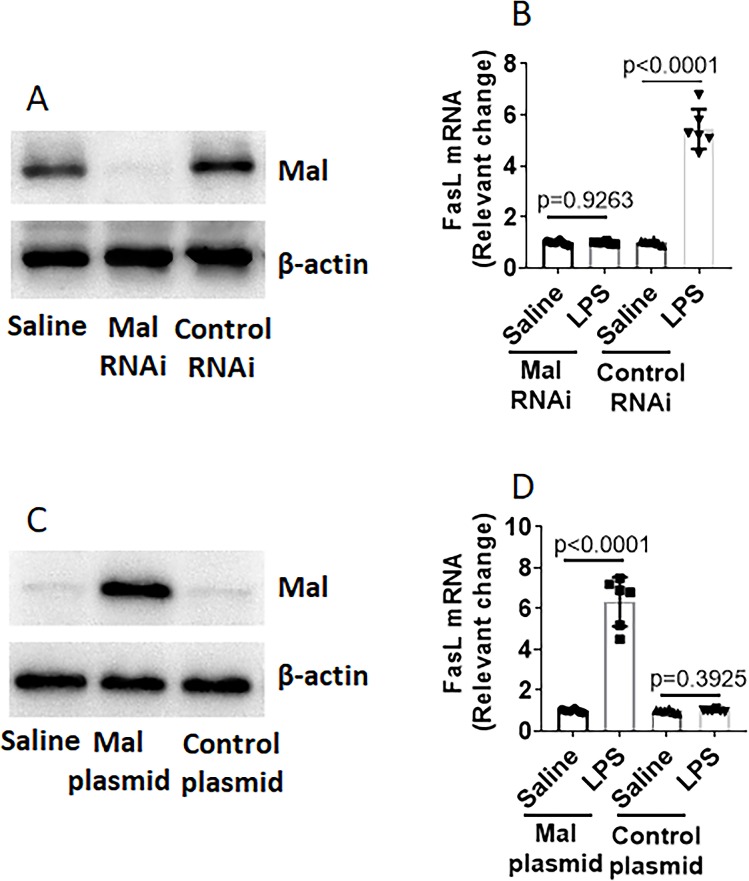
Mal deficiency is associated with FasL mRNA decay.A-B, NC cells were prepared and exposed to cisplatin in the culture for 48 h. The cells were then washed with fresh medium and treated with Mal RNAi to knock down Mal expression (A). The cells were cultured in the presence or absence of LPS (100 ng/ml) for 48 h. The bars indicate the levels of FasL mRNA (B). C-D, LC cells were prepared; the cells were transfected with Mal-expressing plasmids or control plasmids to restore the expression of Mal (C). The cells were exposed to cisplatin in the culture for 48 h to up regulate the expression of FasL. After washing with fresh medium, the cells were cultured in the presence or absence of LPS (100 ng/ml) for 48 h. The bars indicate the levels of FasL mRNA in the cells. Data of bars are presented as mean ± SEM. Each dot in bars presents data obtained from one sample. Statistics: t test.